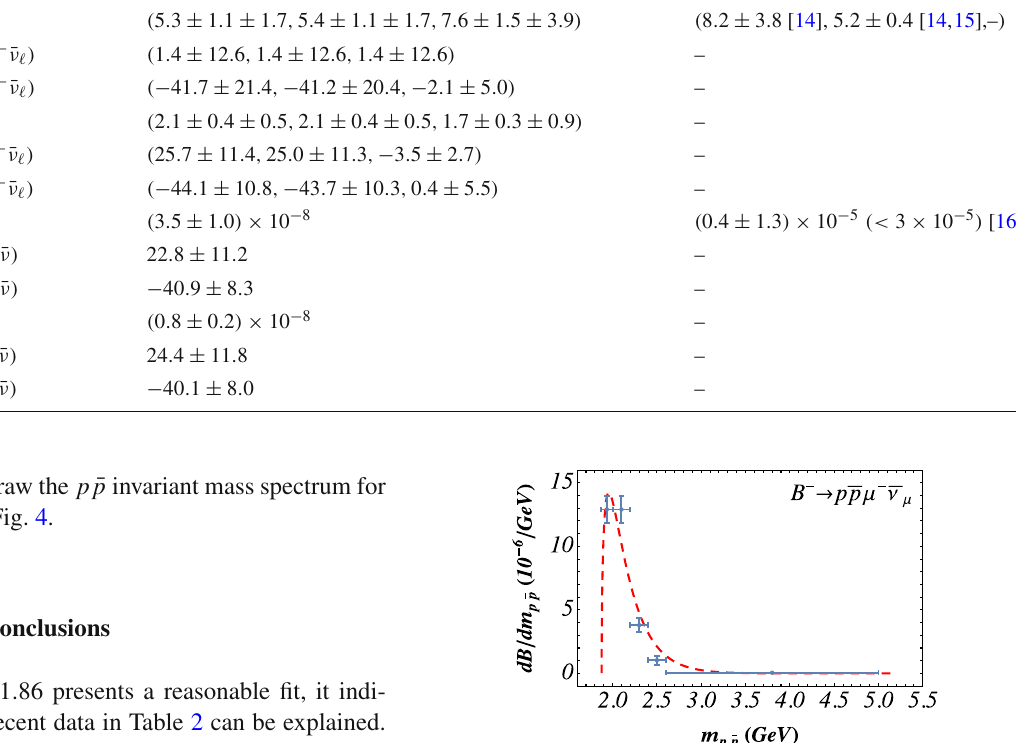
Table 3 Our calculations for the semileptonic B → B ¯ B (cid:3) L ¯ L (cid:3) decays. For B ( B → B ¯ B (cid:3) (cid:9) ¯ ν (cid:9) ) , the values in the parentheses correspond to (cid:9) = ( e ,μ,τ) , where the first and second errors come from | V Decay modes